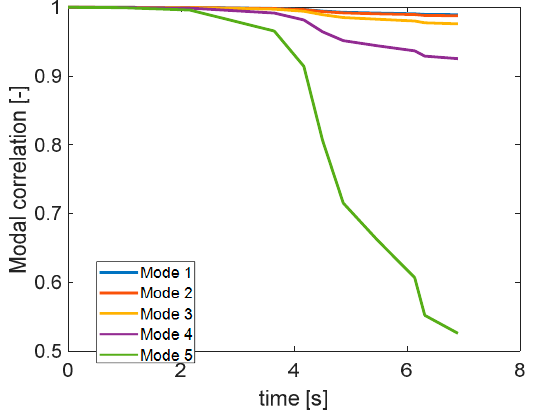
Figure 34. Modal correlation with burn time.